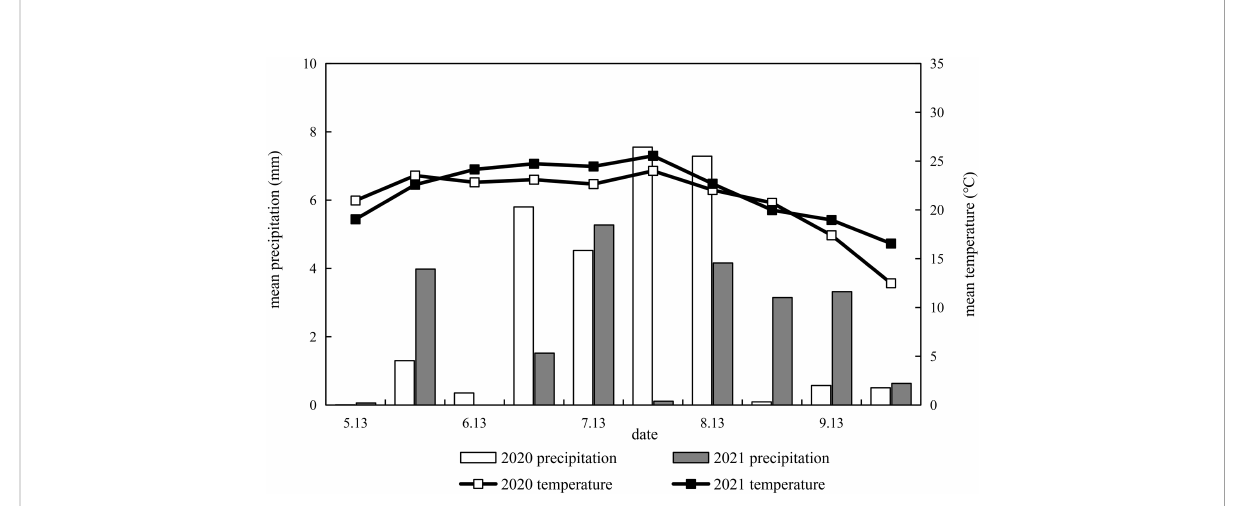
FIGURE 1 Dynamics of precipitation and temperature during millet growing seasons in 2020 and